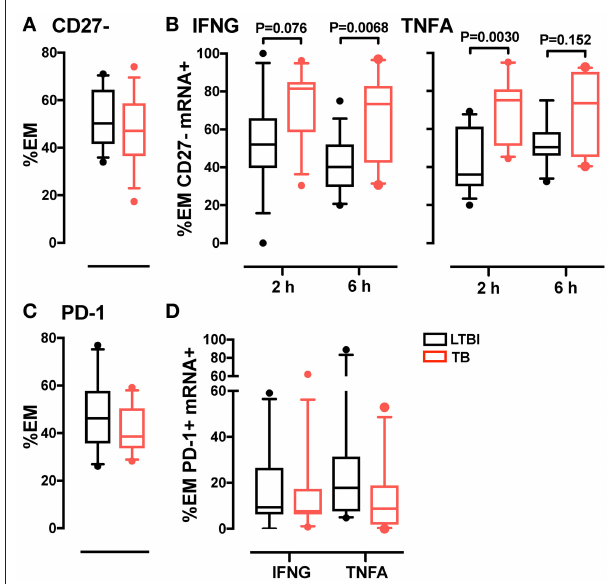
FIGURE 3 | Analysis of CD27 and PD-1 expression in CD4 EM memory T cells. (A) CD27 expression in EM CD4T cells. Data from each patient were plotted as the mean of the frequency of total EM CD4T cells in unstimulated and stimulated samples at 2 and 6h. LTBI n = 16, TB n = 15. (B) Frequency of CD27- memory T cells in IFNG and TNFA expressing cells. Data were expressed as frequency of the total IFNG or TNFA expressing cells in EM CD4T cells from donors after 2 and 6h of PPD stimulation. LTBI n = 16, TB n = 15. (C) PD-1 expression in EM CD4T cells. Data were expressed as the mean of the frequency of total EM T cells in unstimulated and stimulated samples at 2 and 6h. LTBI n = 10, TB n = 11. (D) PD-1 expression in EM CD4T cells expressing IFNG and TNFA mRNA. Data were expressed as the frequency of the total IFNG or TNFA expressing cells in EM subsets at 6h. Similar results were observed at the 2-h time point (data not shown). LTBI n = 10, TB n = 11. Gating strategy utilized for CD27 and PD-1 analysis is described in Supplementary Figures 5C,D . The Wilcoxon two-sample test was used to analyze differences between LTBI and active TB donors. The box plots show lower quartile, median, and upper quartile of the distribution. The upper and lower whiskers represent the 90th and 10th percentile. Extreme values (below the 10th percentile and above the 90th percentile) are shown as ( • )